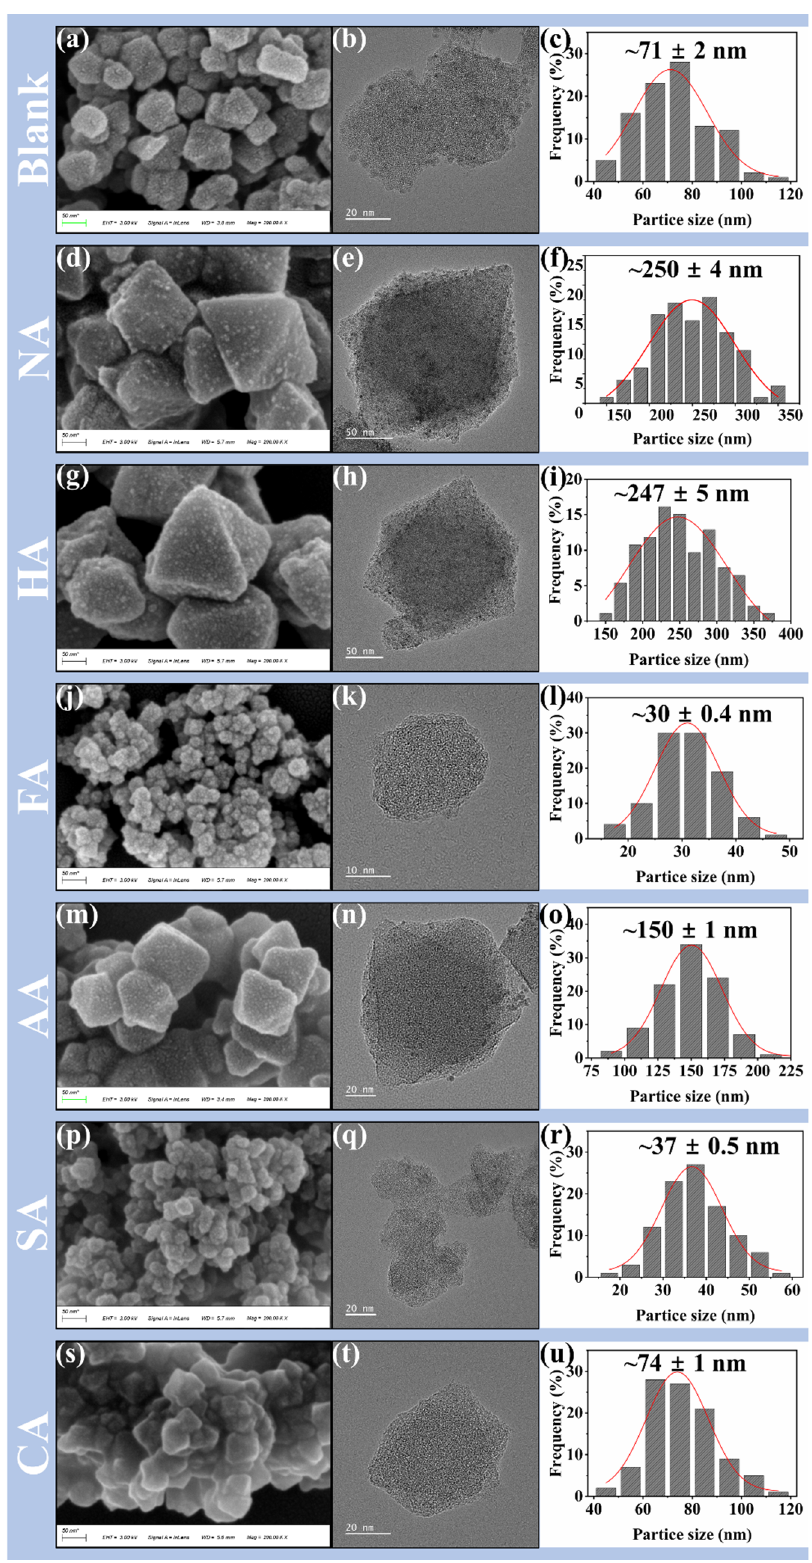
Figure 2. SEM (scale bar is 50 nm) images, TEM images, and particle size distribution images of ( a – c ) blank sample, ( d – f ) nitric acid, ( g – i ) hydrochloric acid, ( j – l ) formic acid, ( m – o ) acetic acid, ( p – r ) succinic acid, and ( s – u ) citric acid.